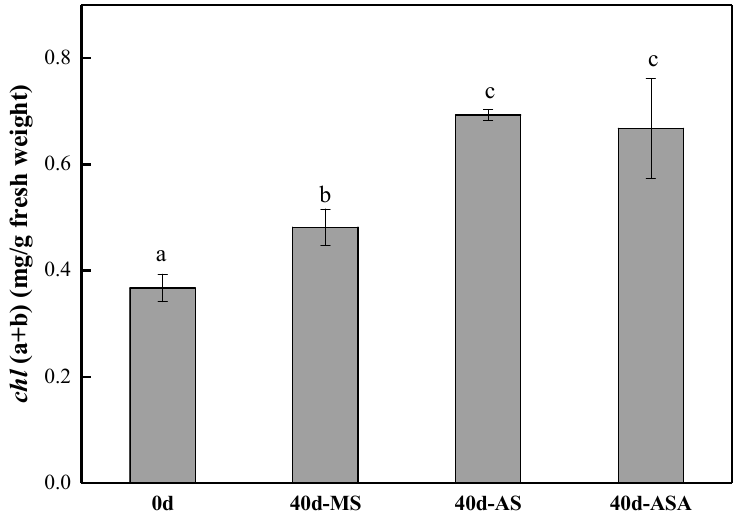
Figure 5. Total chlorophyll content of V. natans in MS, AS and ASA